Question: Summarize what this figure shows in one sentence.
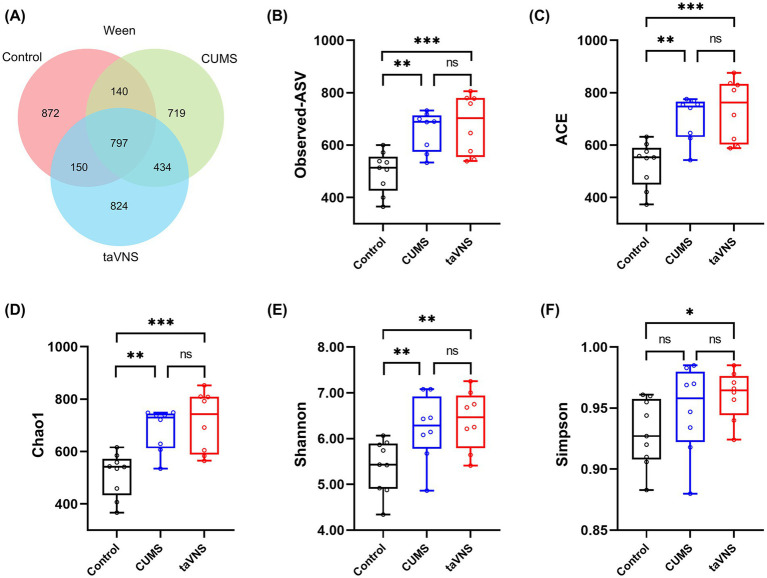
Answer: Alpha diversity of gut microbial in rats of each group ( n = 9 for Control group; n = 8 for CUMS and taVNS groups). (A) The number of common and unique AVSs among the 3 groups is displayed by the Venn diagram. (B–F) Alpha diversity analysis indices, including the (B) observed-ASVs, (C) Ace index, (D) Chao1 index, (E) Shannon index, and (F) Simpson index. * p < 0.05, ** p < 0.01, *** p < 0.001, ns, no significance.